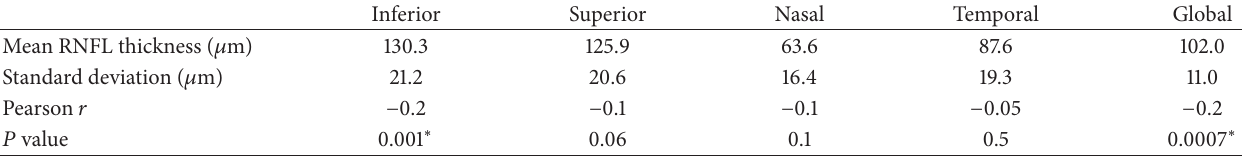
Table 1: Pearson correlation between anterior chamber depth and the global and quadrant retinal nerve fiber layer.